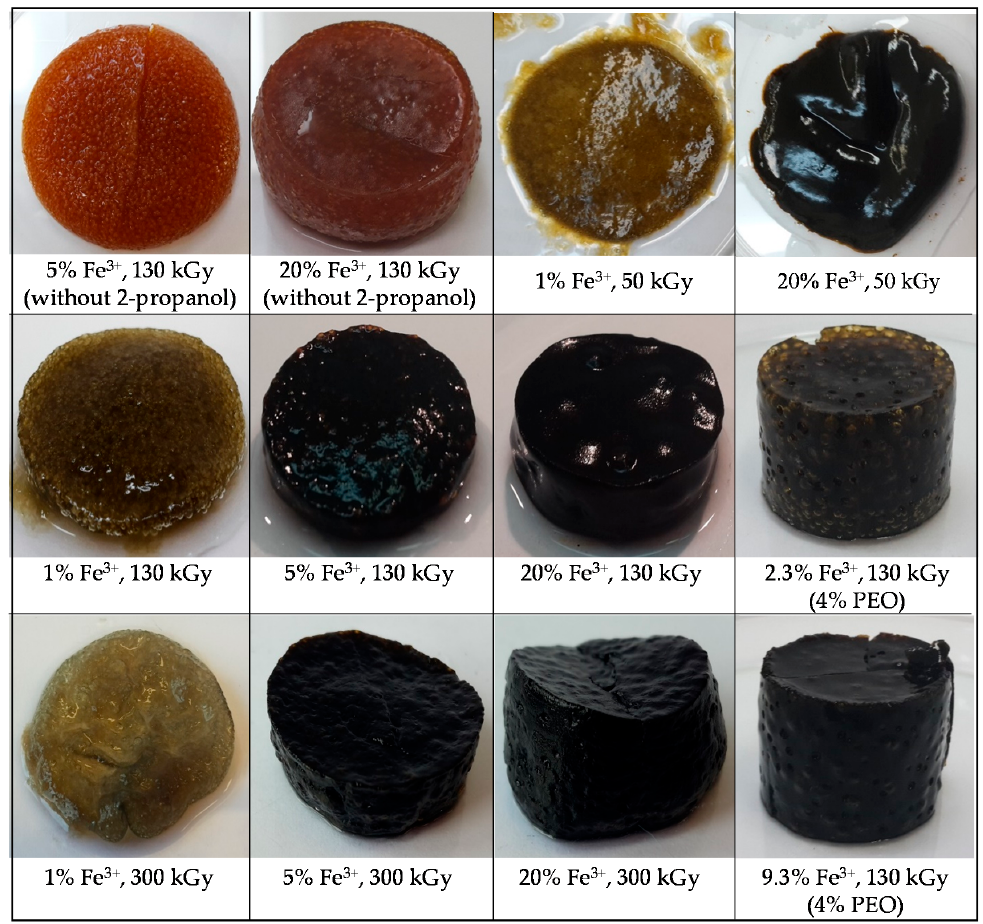
Figure 2. The photographs of PEO/Fe-oxide nanocomposite gels obtained from suspension with